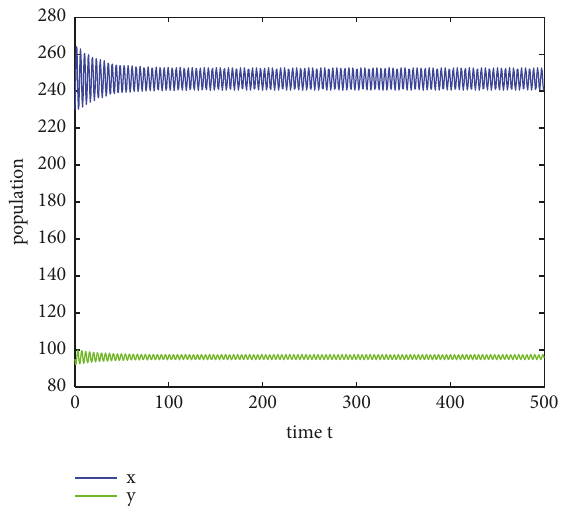
Figure 13: A Time series diagram for prey and predator. Existence of periodic solution around the interior equilibrium 𝐸 ∗ = (𝑥 ∗ , 𝑦 ∗ ) for delayed model (3) with the time delay 𝜏 1 = 𝜏 2 = 0.19 , where the parameter values are 𝑥(0) = 230 , 𝑦(0) = 95 , 𝐴 = 0.01 , 𝑟 = 2.65 , 𝐾 = 900 , 𝑎 = 0.02 , 𝑐 = 0.215 , and 𝑚 = 1.06 .